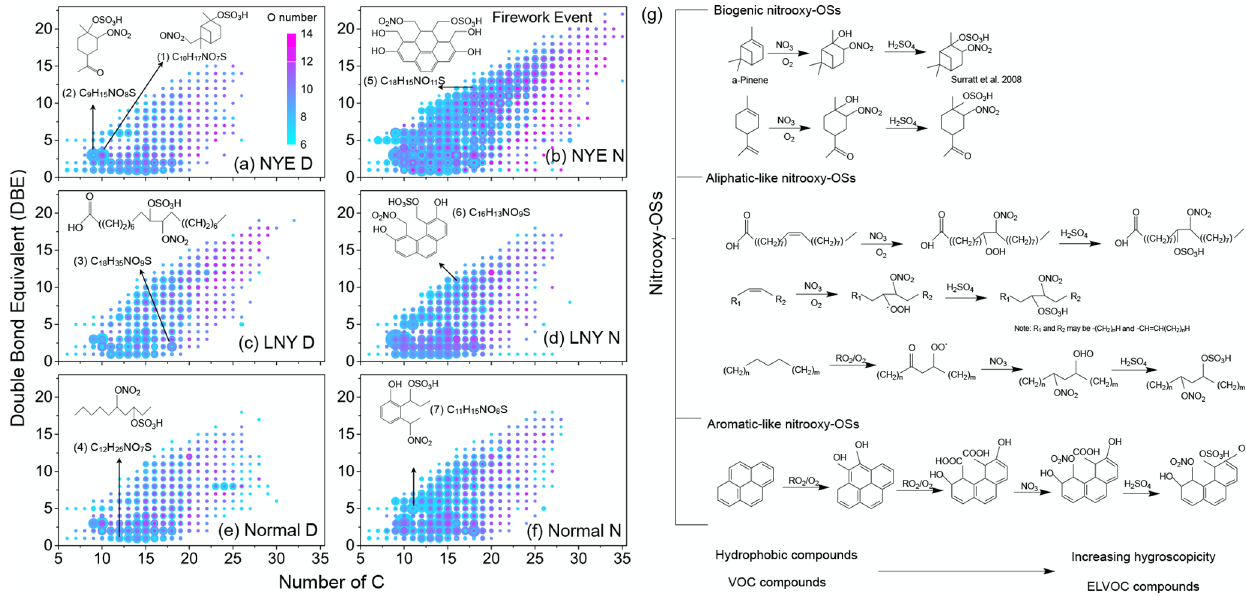
Figure 4. (a–f) DBE vs. C number for N 1 O n S 1 species. The color bar shows the number of O atoms. The size of the plots denotes the relative intensities of nitrooxy OSs on a logarithmic scale. (1)–(7) are proposed structures of some nitrooxy OSs, among which (1) and (2) have been reported previously (Surratt et al., 2008). Their relative intensities in each sample are shown in Table S3. (g) The proposed potential formation mechanisms of various groups of nitrooxy